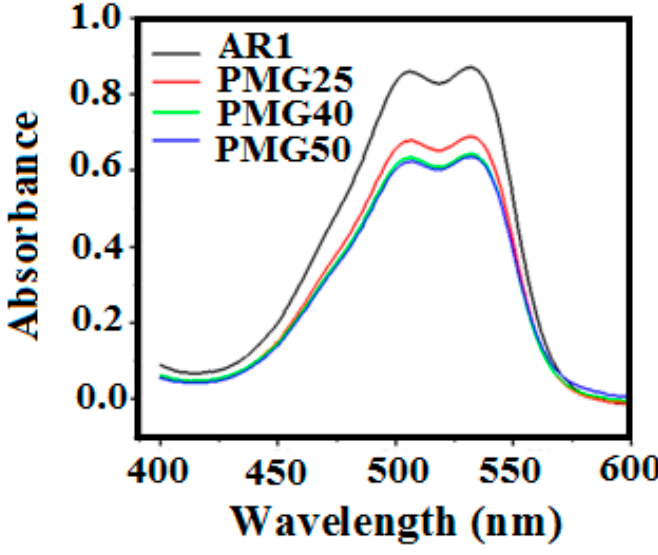
Figure 8. UV-Vis absorption spectra of AR1 dye with and without PMG composites.